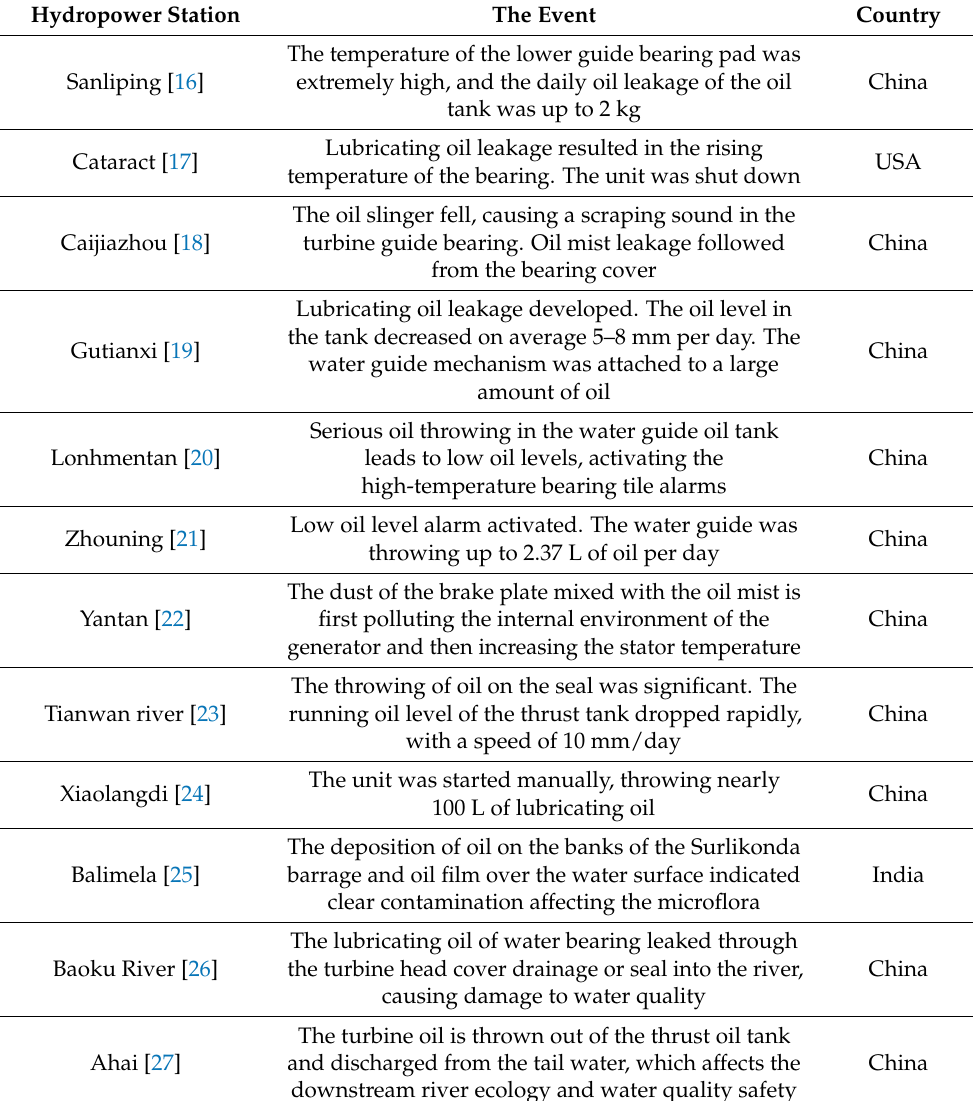
Table 1. Oil mist leakage of bearings in power